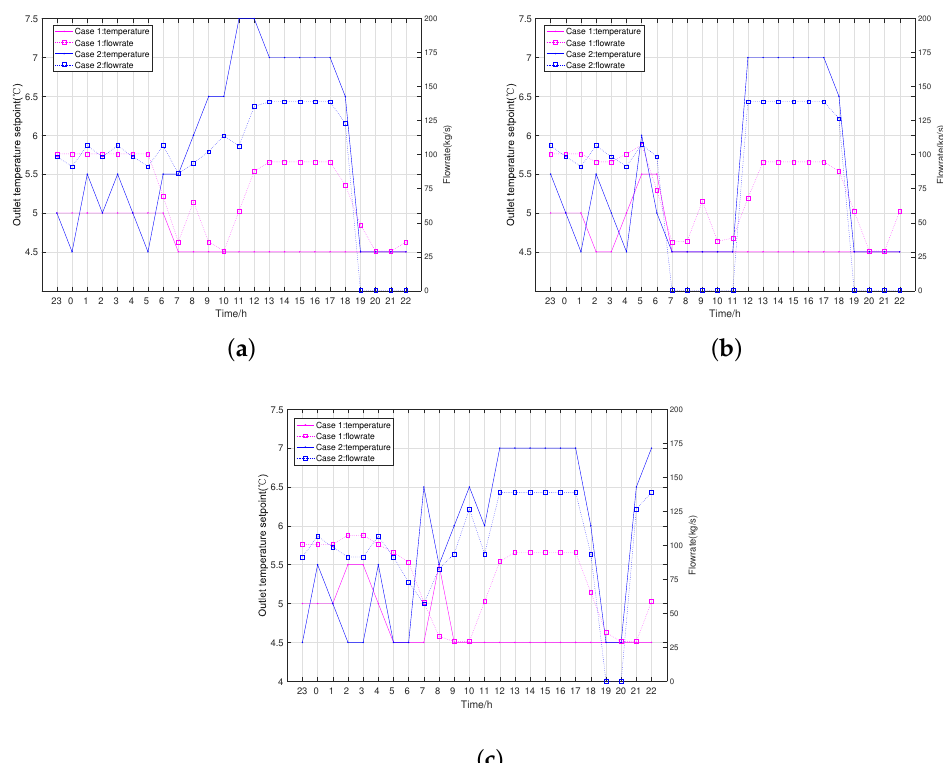
Figure 11. The operation result of all ECs from the perspective of flowrate and temperature analysis. ( a ) the temperature and flowrate results of EC1; ( b ) the temperature and flowrate results of EC2; ( c ) the temperature and flowrate results of